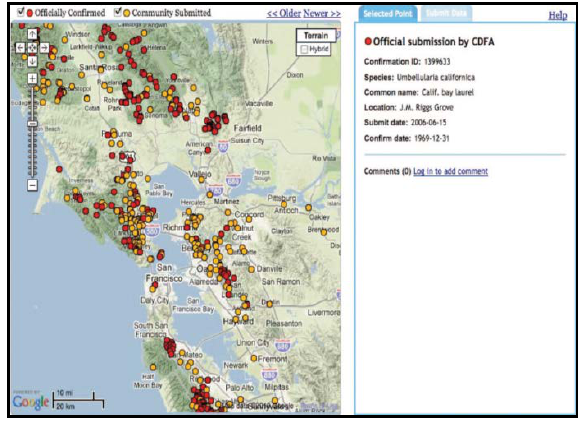
Figure 3: San Francisco Bay Area in OakMapper website